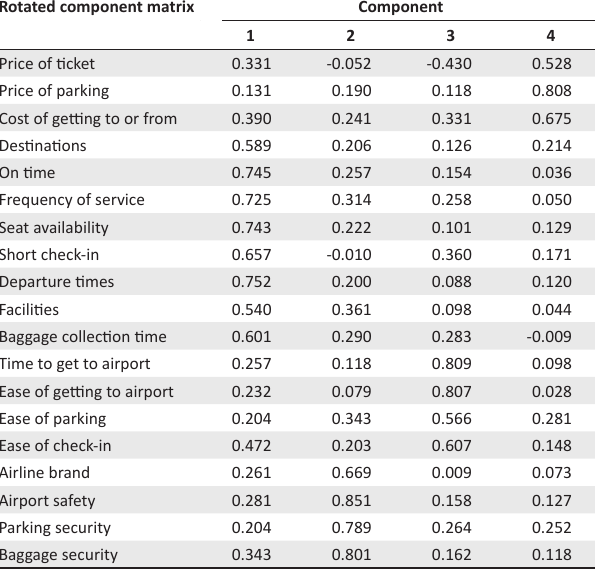
TABLE 3: Factor rotation – four factors (2013).